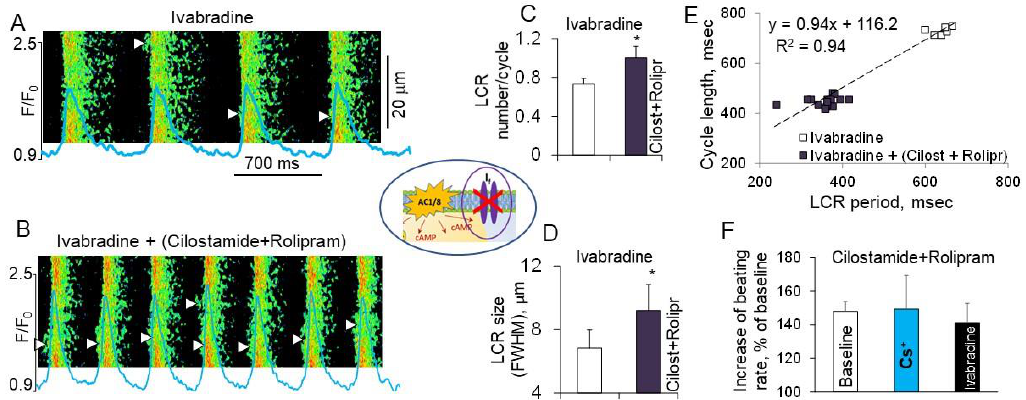
Figure 10. Concurrent (PDE3 + PDE4) inhibition markedly increases LCR parameters, shortens the LCR period and spontaneous SANC cycle length despite suppression of I f current by either ivabradine or Cs + . ( A , B ) Confocal line scan images of a representative intact rabbit SANC depicting AP-induced Ca 2+ transients and LCRs (arrowheads) during spontaneous beating of SANC in presence of 5 µmol/L ivabradine ( A ) and ( B ) following inhibition of (PDE3 + PDE4) by 0.3 µmol/L cilostamide and 2 µmol/L rolipram. Normalized subsarcolemmal fluorescence averaged over an image width is shown in blue. ( C ) In the presence of ivabradine, dual (PDE3 + PDE4) inhibition markedly increased the number of LCRs per each spontaneous cycle (left, n = 5 SANC) and ( D ) the LCR size (right, n = 5 SANC); ( E ) (PDE3 + PDE4) inhibition also markedly decreased the LCR period, which was accompanied by the decrease in the spontaneous SANC cycle length. ( F ) Average acceleration of the firing rate by dual PDE3 + PDE4 inhibition presented as % of baseline: in the absence (n = 9 SANC) or presence of either 2 mmol/L Cs + (n = 6 SANC) or 5 µmol/L ivabradine (n = 5 SANC); % of baseline was calculated relative to firing rate before treatment with the combination of cilostamide + rolipram. t -test * p < 0.05. ( A – F , modified from [11]).